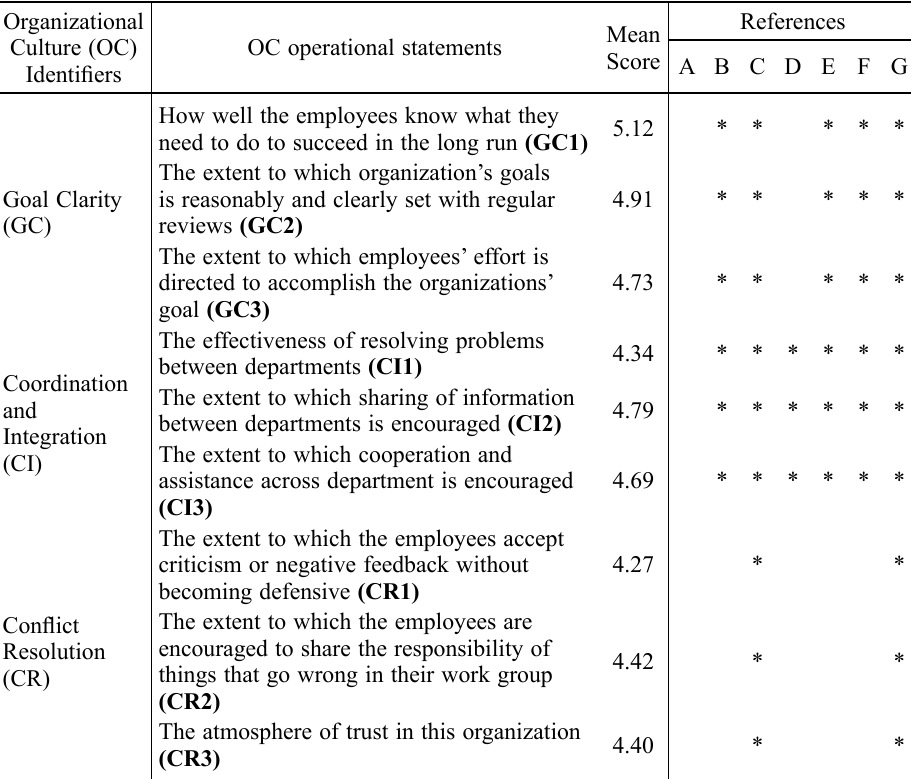
Table 1. Identifiers of Organizational Culture